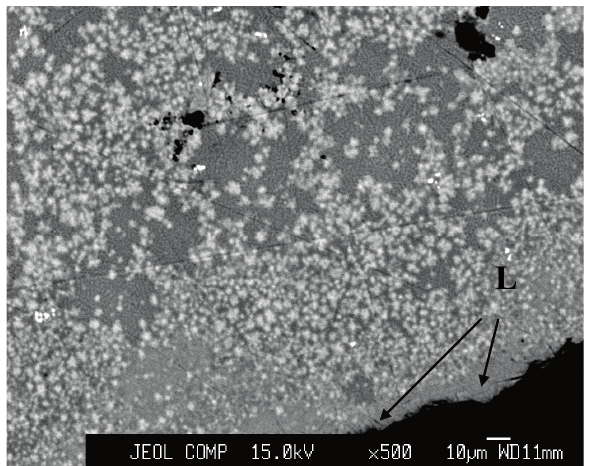
Figure 6. Microstructure of quenched Cu-Zr-Al alloy. Ar- rows show amorphous